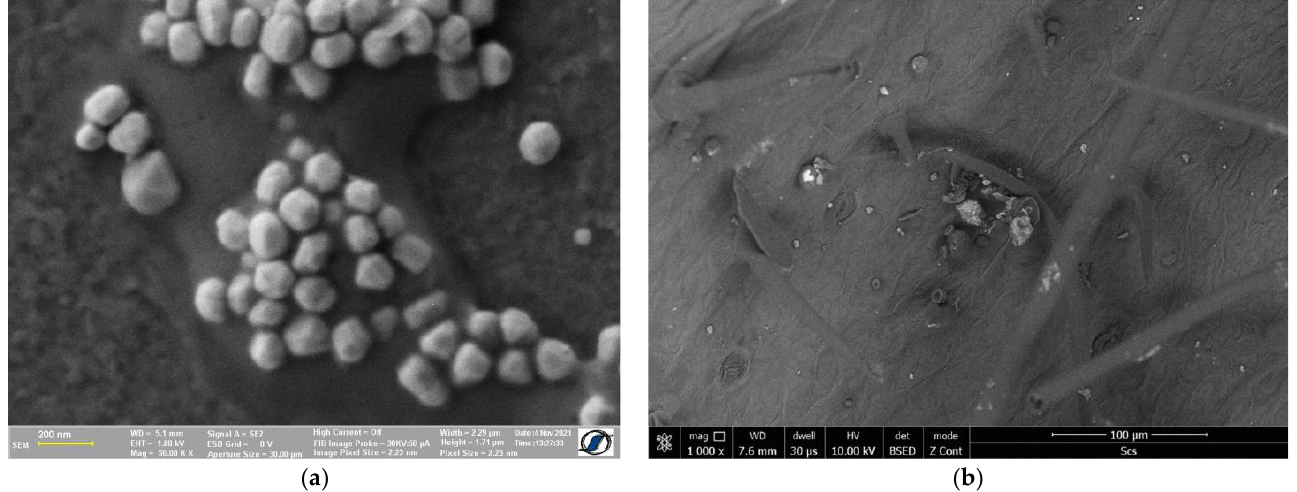
Figure 8. ( a ) Two-dimensional image of the AgNPs (citrate coated) obtained by the SEM technique. ( b ) Two-dimensional image of the curcuma sample obtained by the SEM technique (magnitude: 100 μm).